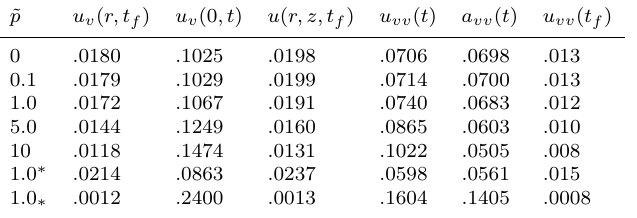
Table 1. The maximal values of u v ( r,t f ) , u v (0 ,t ) , u ( r,z,t f ) , u vv ( t ) , a vv ( t ) and u vv ( t f ) depending on ˜ p ˜